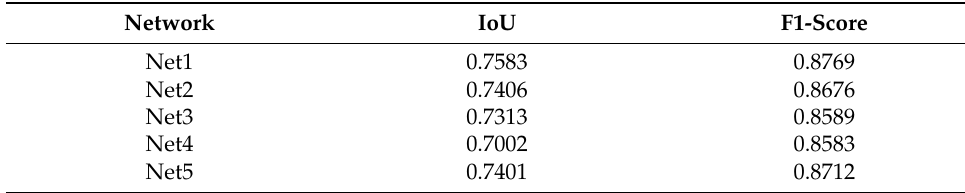
Table 2. Ablation study of our SSDBN.